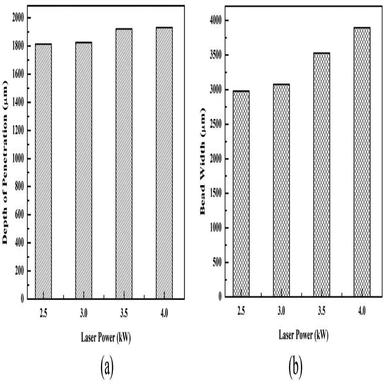
Influence of laser power on (a) depth of penetration and (b) throat width/bead width.